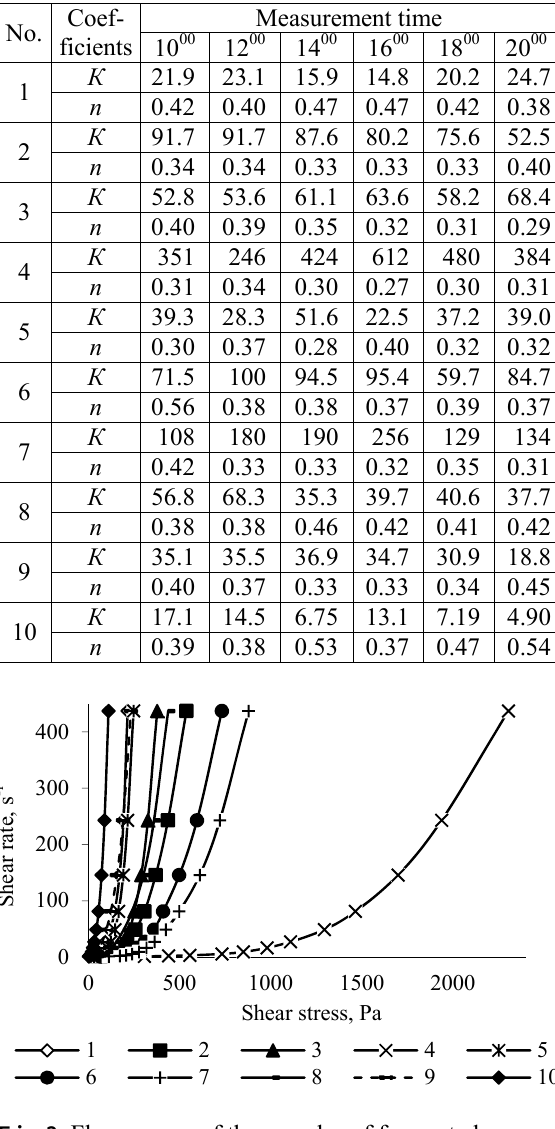
Fig. 3. Flow curves of the samples of fermented pregelatinized flour 1–10 at the end of fermentation. To analyze the optimal composition of pregelatinized flour, some flow curves have been plotted for the values of dependence of rate on shear stress at the end of fermentation of pregelatinized flour, as shown in Fig. 3. Analyzing the data obtained, it can be concluded that the sample numbered 10 has the lowest shear stress, hence the fermented pregelatinized flour with a 50% content of a starter has the least viscous structure, which allows the sample to be dried more quickly using a moisture analyzer and to preserve lactic acid bacteria. Study of various methods for drying fermented pregelatinized flour for use in the technologies of bakery products made of rye and a mixture of rye and wheat flour. When determining the conditions of drying fermented pregelatinized flour, a number of studies were carried out at the Kemerovo